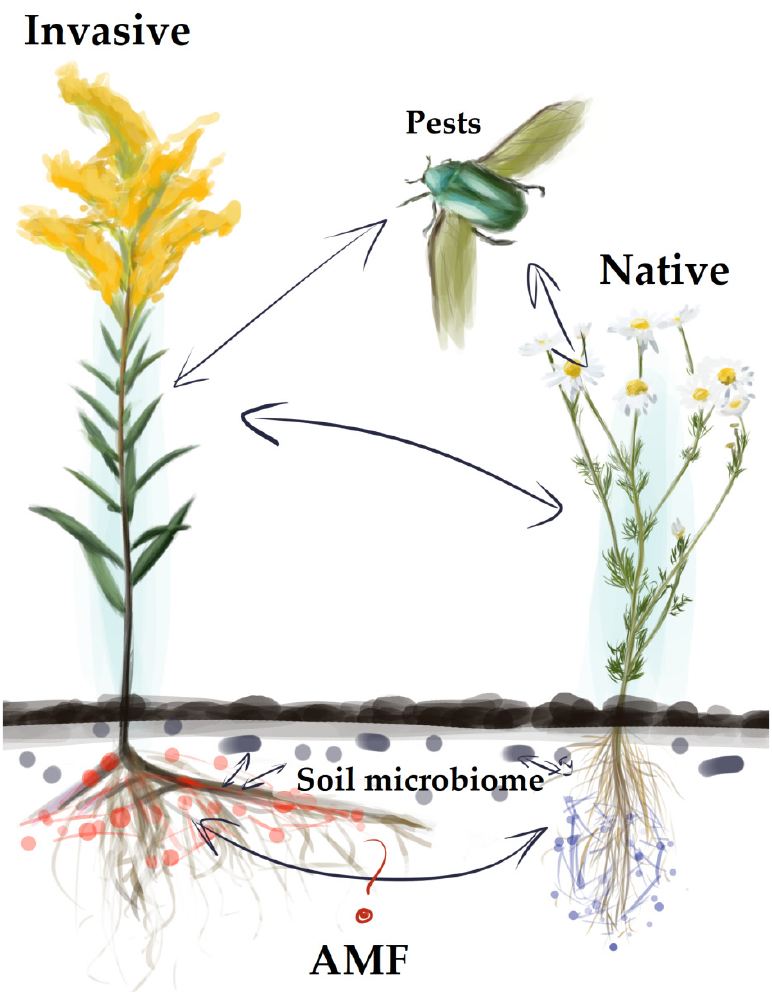
Figure 2. Interactions with invasive Asteraceae species in phytocenoses.